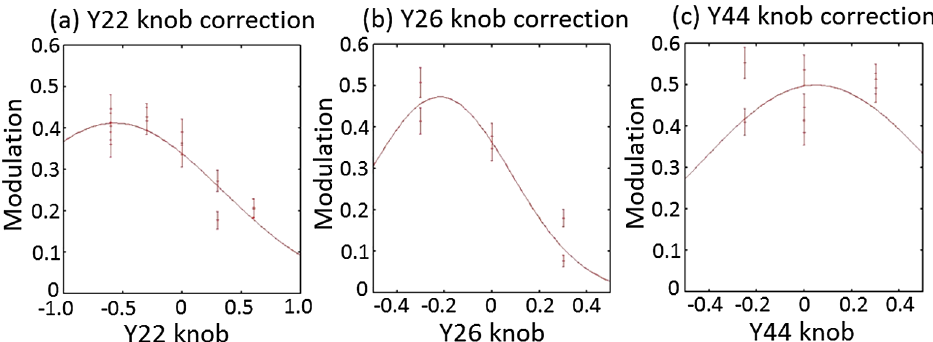
FIG. 15. Second order optics knob corrections with skew sextupole magnets in December 2012. Corrections were made to maximize the IP-BSM modulation depth in 30° mode.